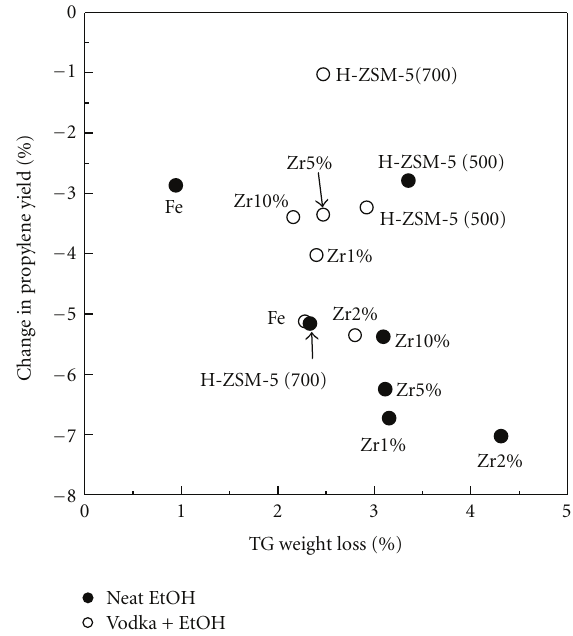
Figure 1: Plots of the initial yield of propylene versus the change in propylene yield over H-ZSM-5 and (Fe or Zr)/H-ZSM-5 catalysts. Numbers in parenthesis denote calcination temperature ( ◦ C).